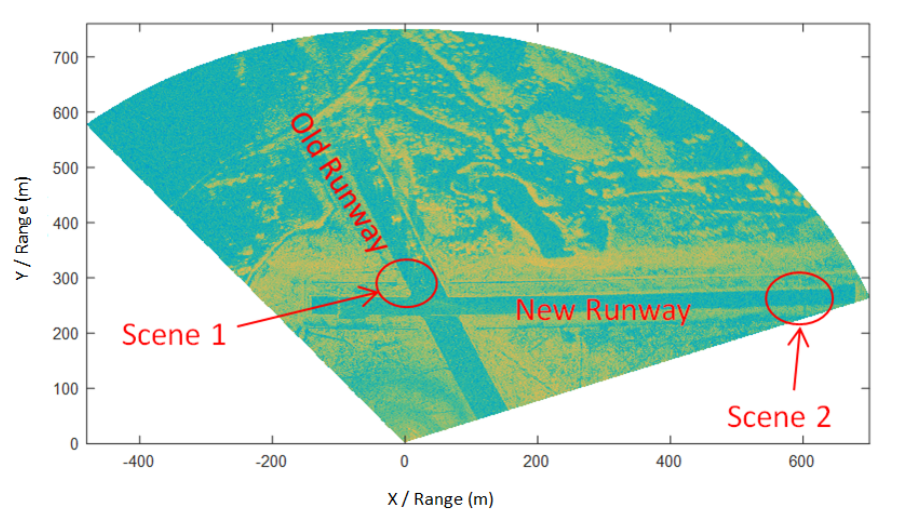
Figure 6. Radar amplitude image of Beijing Miyun Airport.